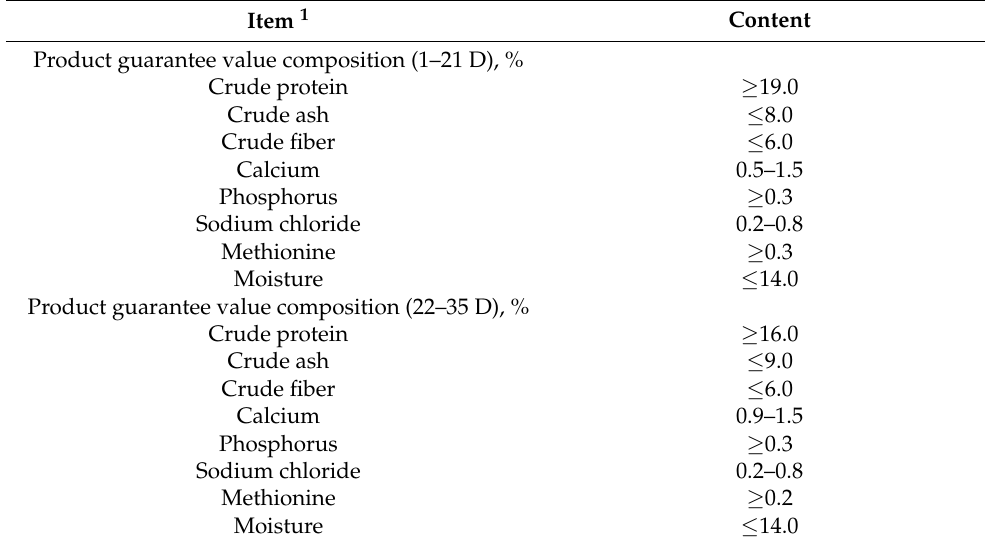
Table 1. Product guarantee nutritional composition in duckling compound feed (1–35